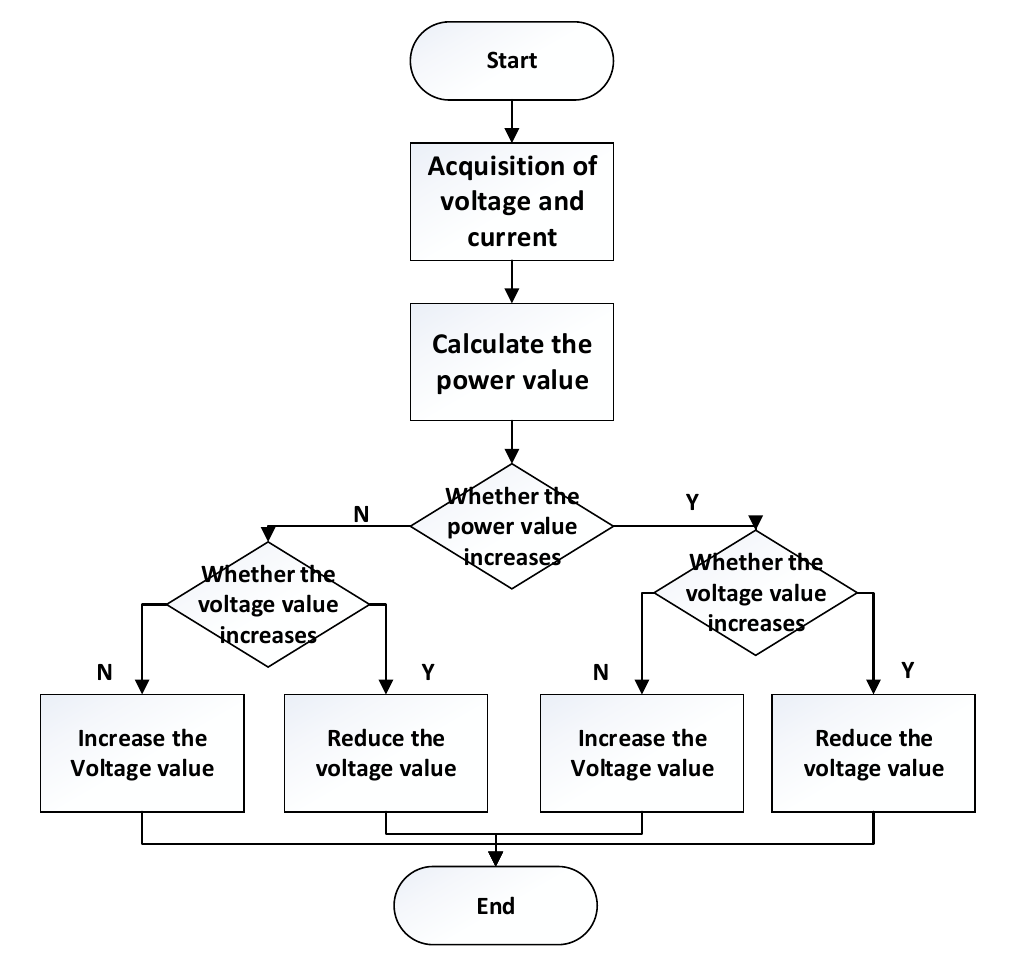
Figure 3. Flowchart of perturbation and observation